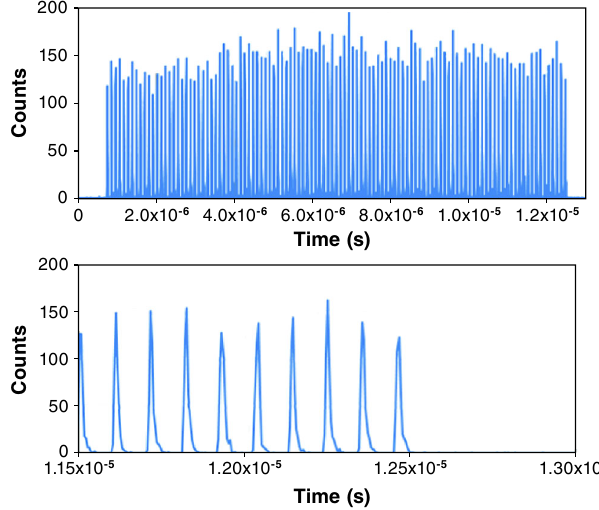
FIG. 17. Time-of-flight spectra of electrons generated by the interaction of the relativistic proton beam with the residual gas. Data were accumulated for 5 minutes due to the low counting rates. The top chart shows the RHIC 111-bunch pattern and portions of the abort gaps preceding and following that pattern. The bottom chart is an expanded view of the last ten bunches to show the asymmetric shape of the peaks (see text).